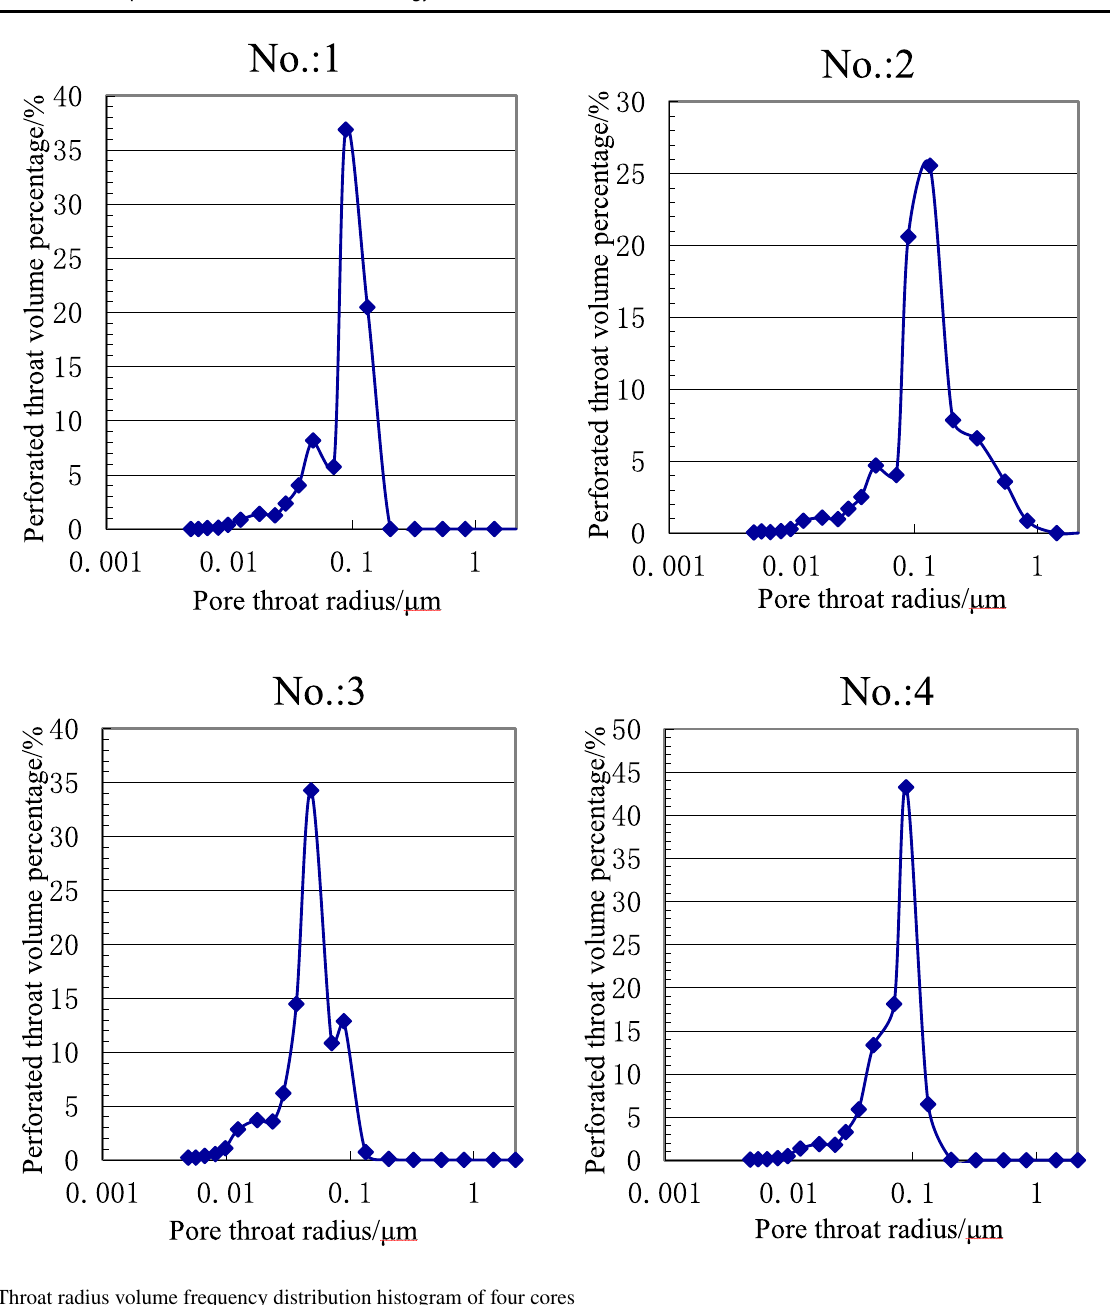
Fig. 6 Throat radius volume frequency distribution histogram of four cores